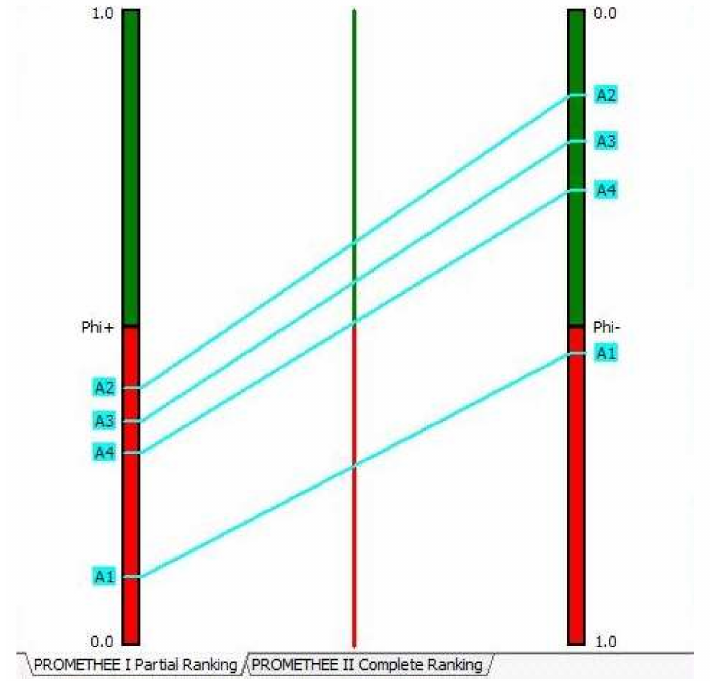
Figure 9. Partial ranking of alternatives based on the PROMETHEE I method, taking into consideration all categories of possible decisions (Asvestades quarry).